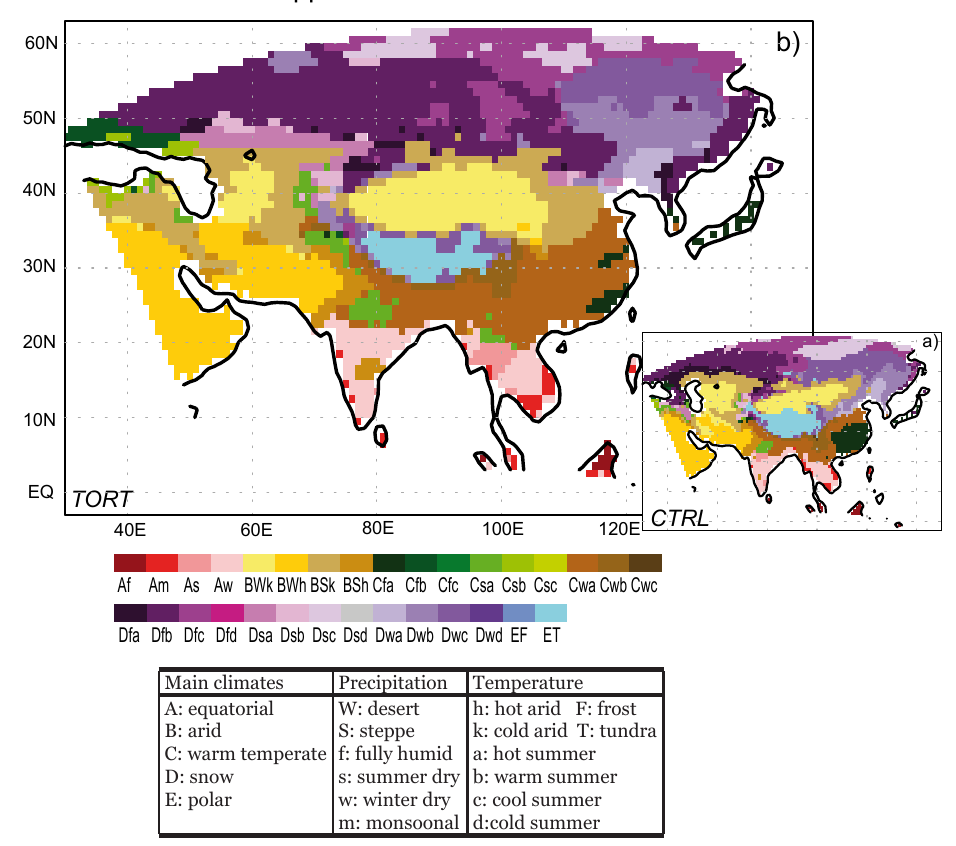
Fig. 7. The K¨oppen-Geiger climate classification. (a) the present-day (CTRL), (b) the Tortonian (TORT). For the present-day classification, the temperature fields are derived from CRU TS 2.1 data set (Mitchell and Jones, 2005). The precipitation fields are derived from GPCC VASClimOv1.1 data set (Beck et al., 2005). To generate a similar data set for the Tortonian classification, the anomalies of the temperature and precipitation between the regional model experiments TORT and CTRL are added to the present-day observation data